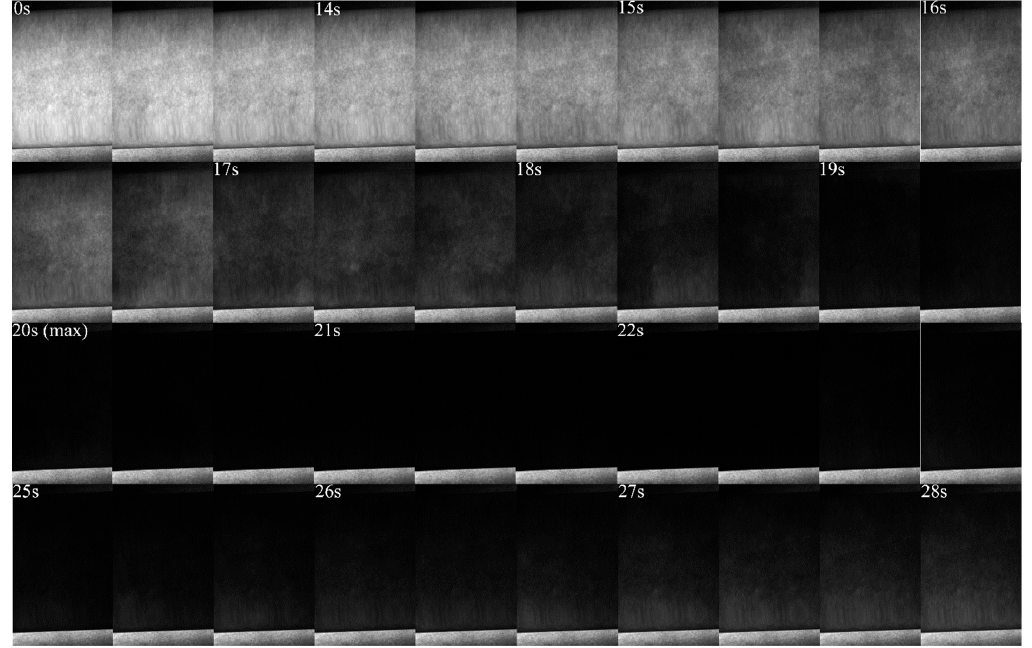
Figure 6. Contaminant evolution at point 1 (168, 138) with initial concentration of 40 mL / L; operating pressure is 3 bar.